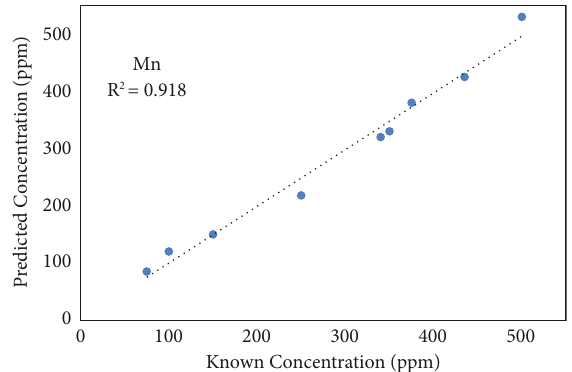
Figure 5: Artificial neural network regression curve of predicted versus known concentration of manganese.